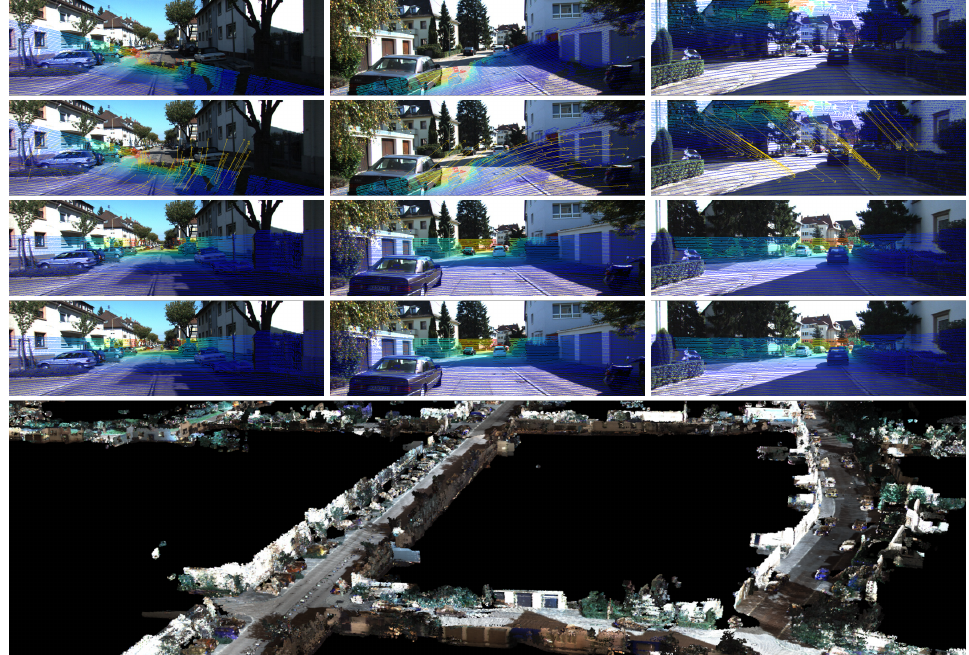
Figure 1. Examples of our proposed CFNet. (First Row) Mis-calibration. (Second Row) The predicted calibration flow. (Third Row) The calibration result predicted by CFNet. (Fourth Row) Ground truth. (Bottom Row) Three-dimensional colorized map generated by fusing the sensors using calibration values provided by our